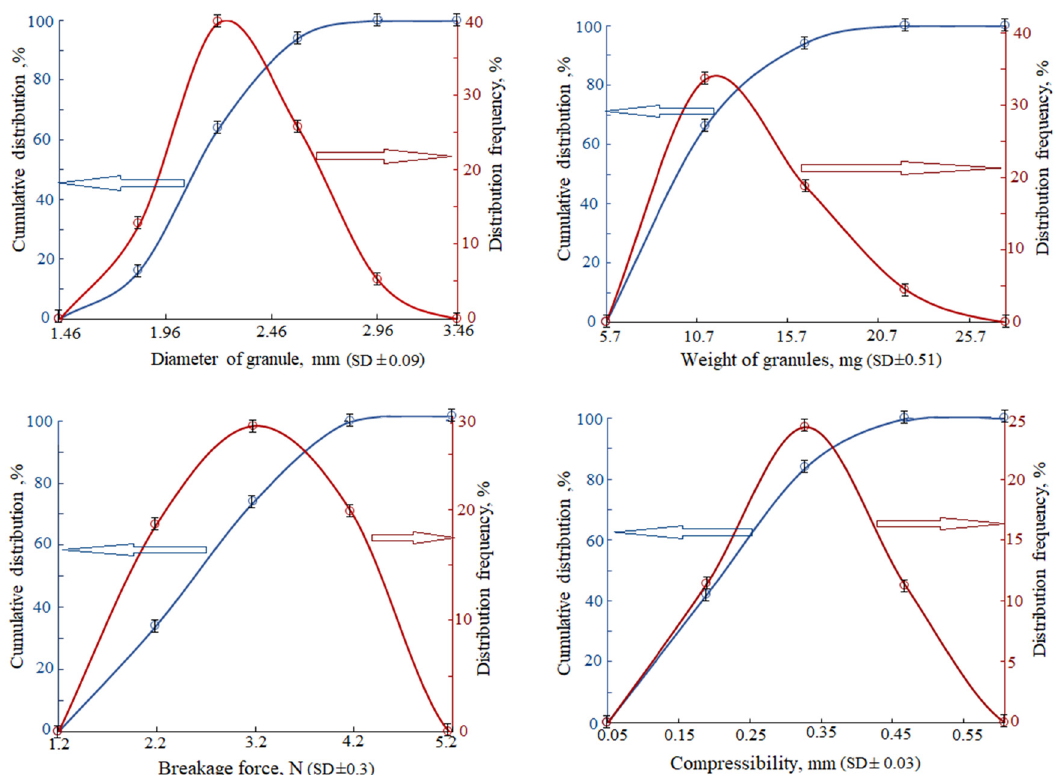
Figure 4: Physical and mechanical properties of the granulated PDP, produced by wetting with water and adding 5%